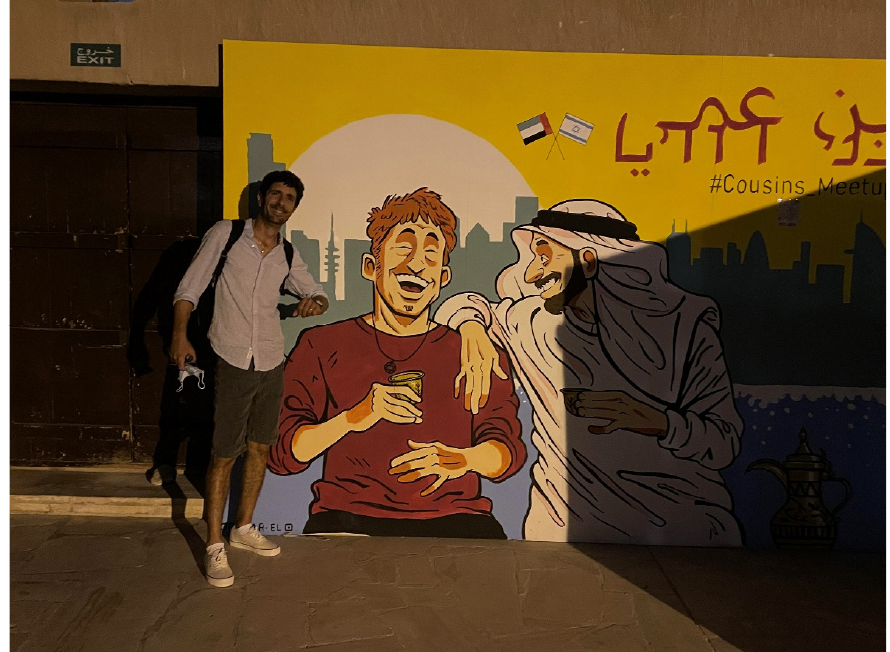
Figure 1. #Cousins Meetup, The graffiti mural with the “Cousins” logo, made by Israeli artist Or Bar El, was dedicated at a ceremony at the Crossroads of Civilization Museum. Photo courtesy of Karmi Menachem, Dubai, May, 2021.